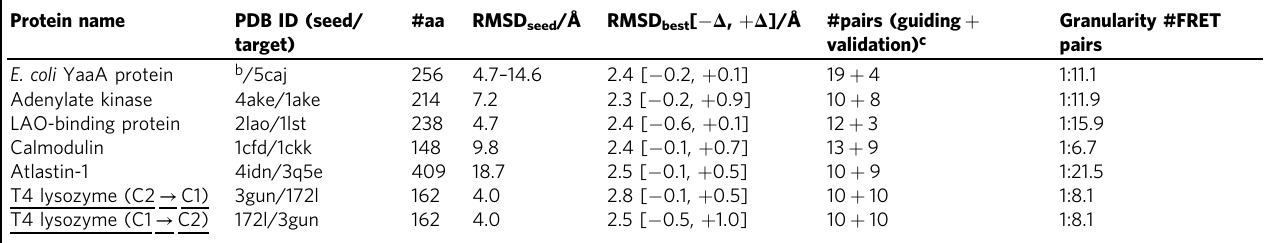
a The starting ensembles, FRET networks, and optimization cycles are summarized for all proteins in Supplementary Fig. 8. b For E. coli YaaA protein, 10 seed structures were selected among the predictions submitted for the CASP11 experiment (target T806). This selection differs from the target crystal structure (RMSD of 4.7 – 14.6Å) and represents different folds and secondary structures. c The number of FRET measurements needed for reliable segregation of models is reported in the #pairs column. Initially predicted FRET pairs are used for guiding, while an extended set of FRET pairs is used for